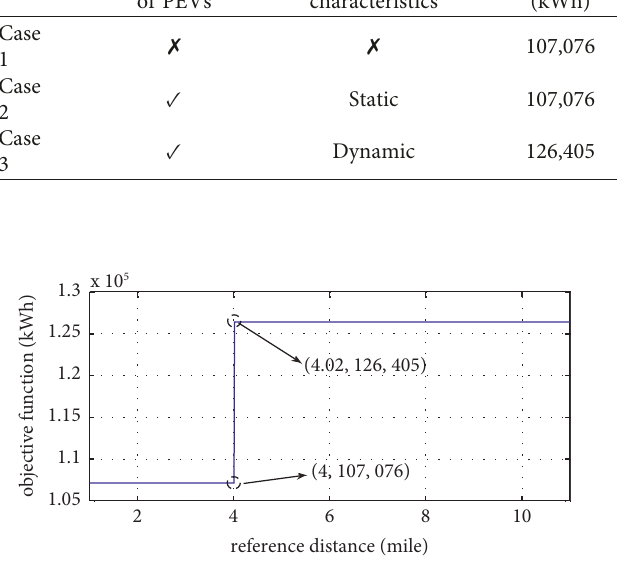
Figure 21: Sensitivity analysis of objective function with respect to different reference distance ( D ref